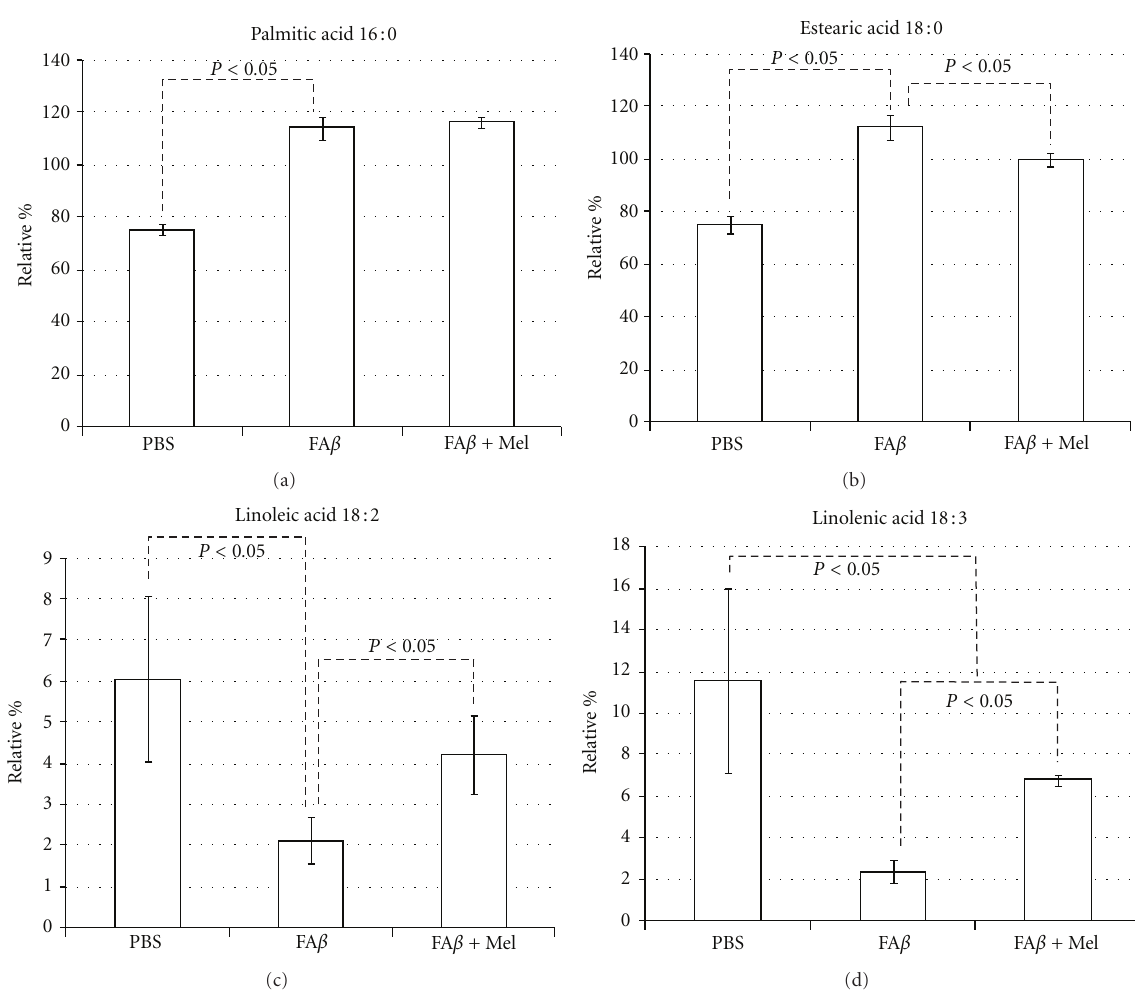
Figure 4: A β and H 2 O 2 (not shown) had similar and highly significant e ff ects on saturated fatty acids particularly on palmitic and estearic acids whose percentages were increased 39 and 37% correspondingly. Linoleic acid was reduced to a third from the control, while linolenic acid was reduced to less than a quart from the control value, as shown. These important e ff ects of A β on specific saturated and unsaturated fatty acids a ff ected the unsaturated/saturated (U/S)